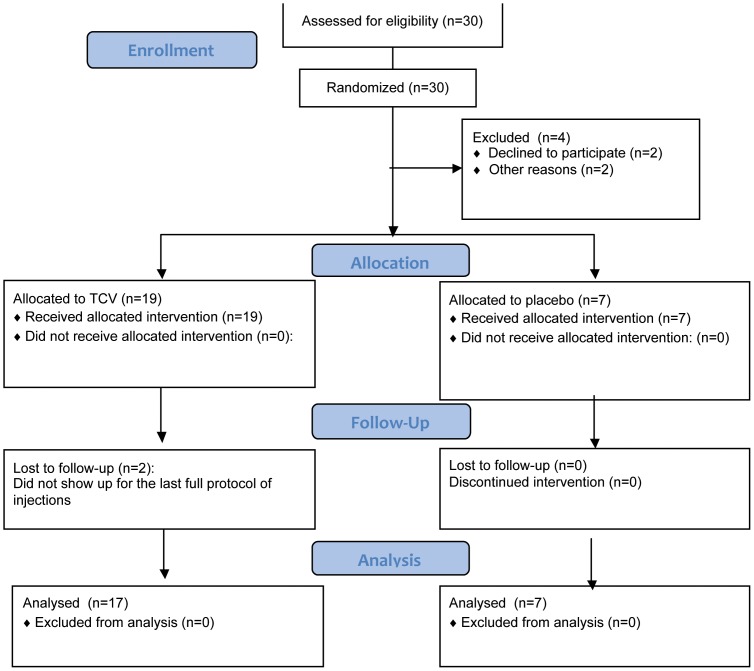
Consort flow chart.